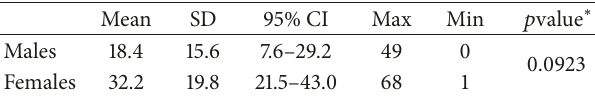
Table 4: Comparison of pain intensity using a VAS (0–100) between males and females for the patients diagnosed with myalgia. There were insufficient data to compare males and females for arthralgia or a combination of muscle and joint